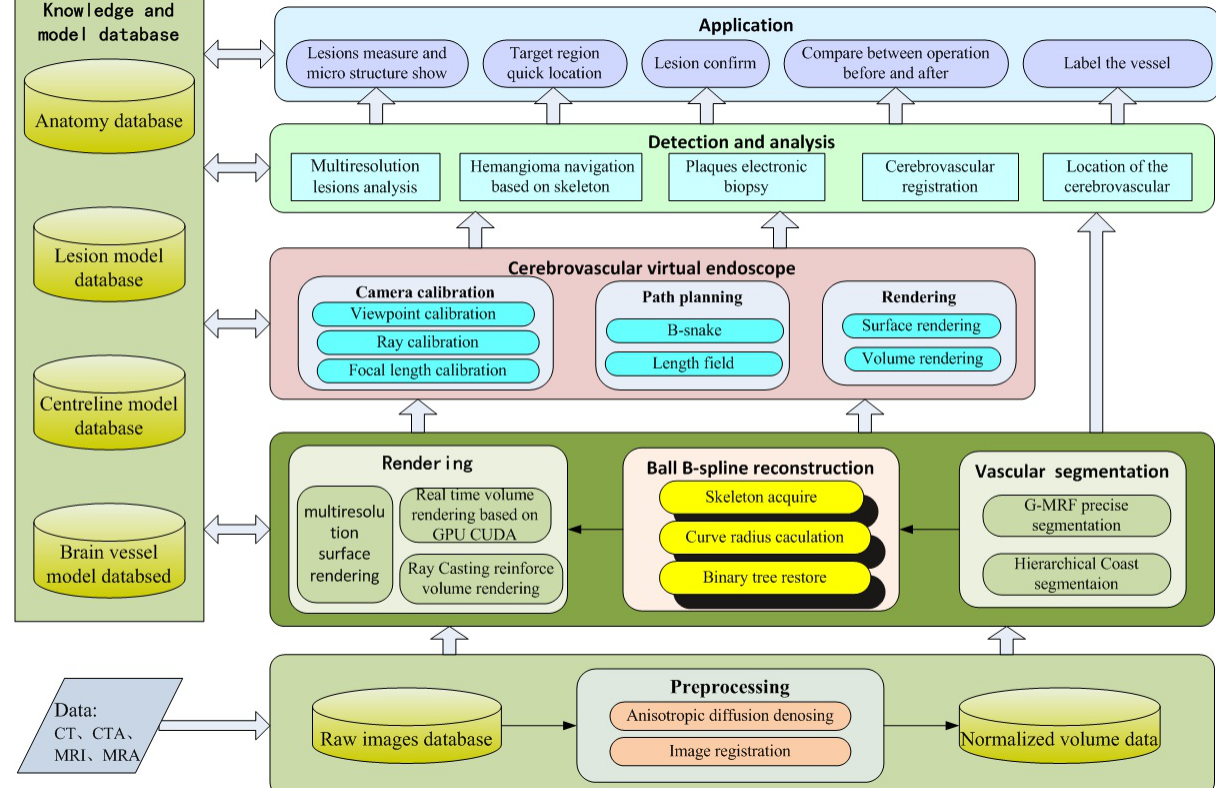
Figure 2. The function structure of medical service platform about cerebrovascular